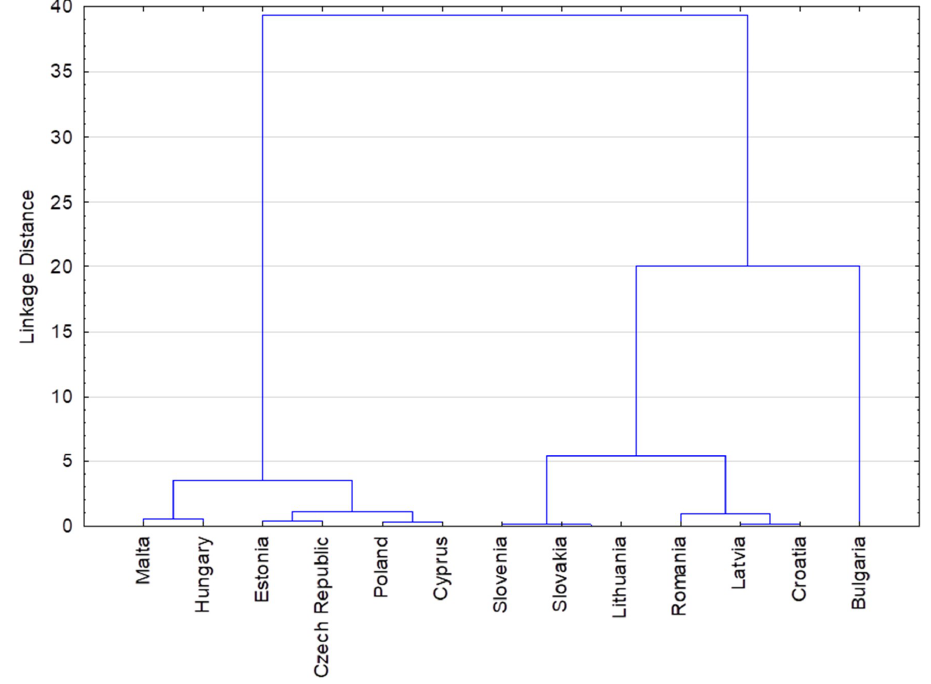
Figure 8. Tree diagram for IRE in